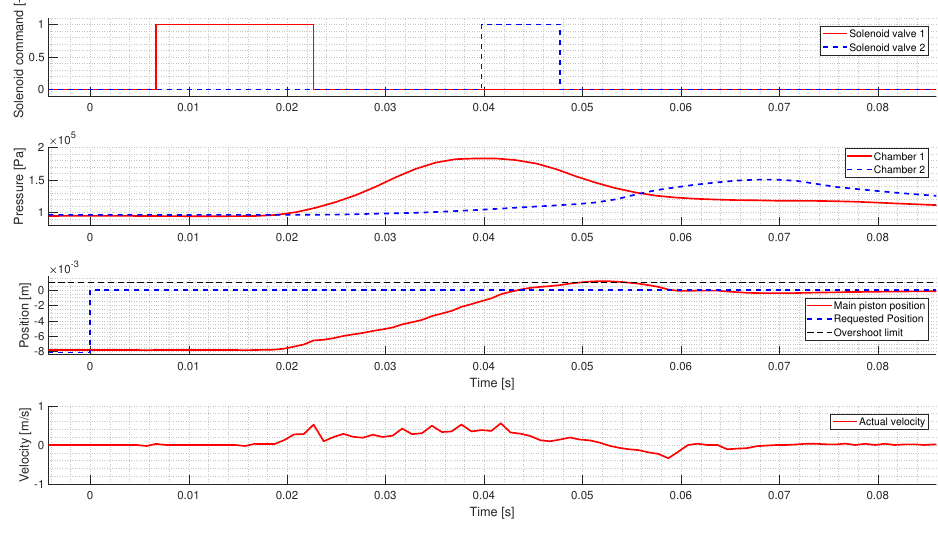
Figure 13. Low to Neutral gear change